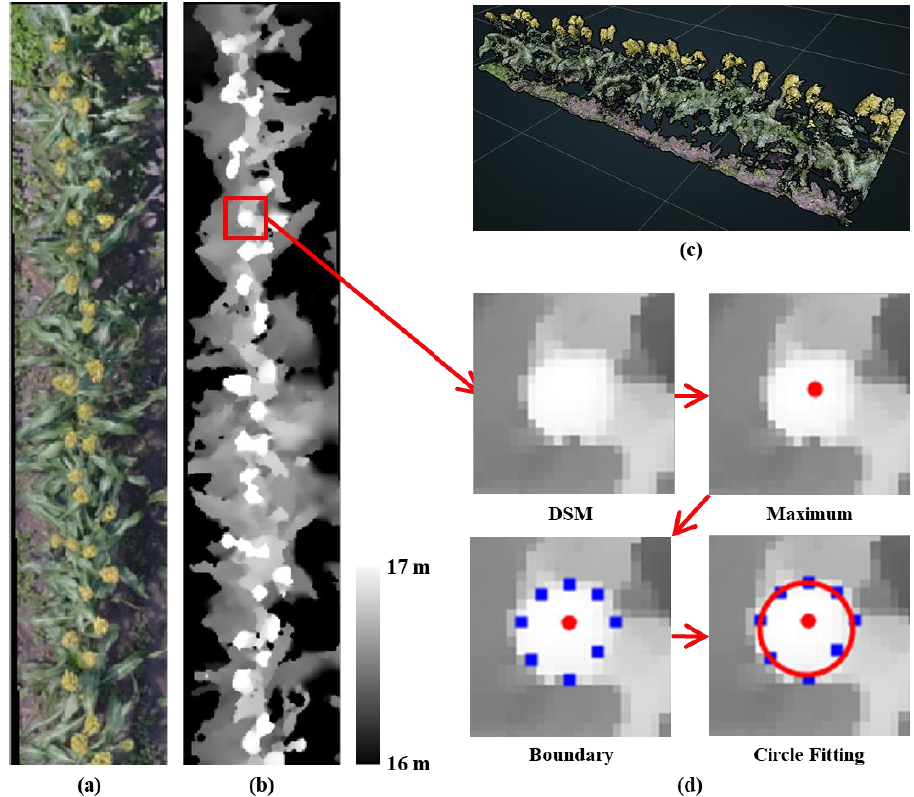
Figure 2. Subset of ( a ) the orthomosiac image and ( b ) the digital surface model (DSM); ( c ) perspective view of RGB-colored 3D point cloud for a single row; ( d ) example of individual panicle detection in DSM, where red and blue dots indicate local maximum and boundary points, respectively; the most suitable circle (red circle) was fitted using boundary points for an individual panicle.